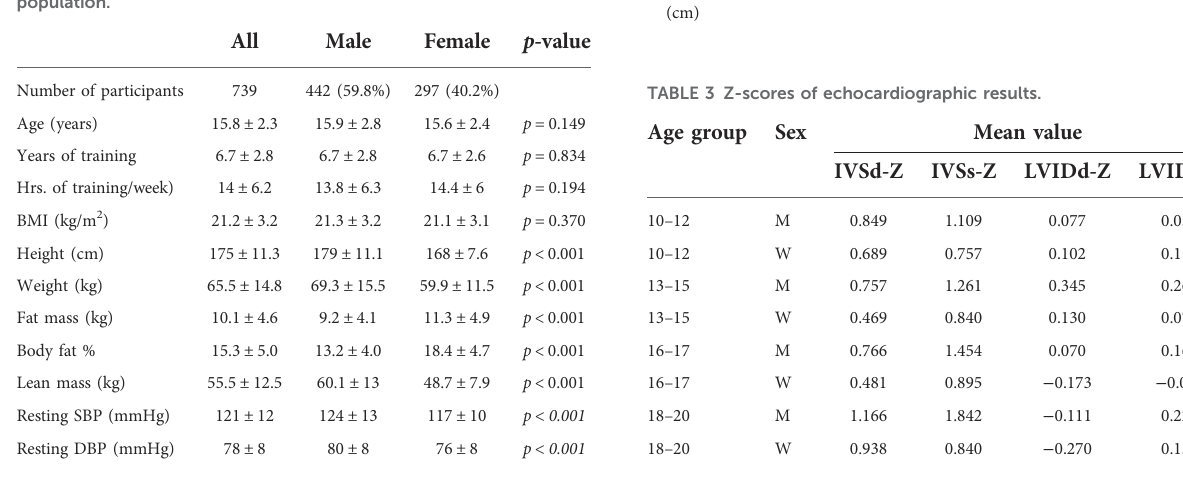
TABLE 1 Baseline anthropometric and clinical characteristics of study population.